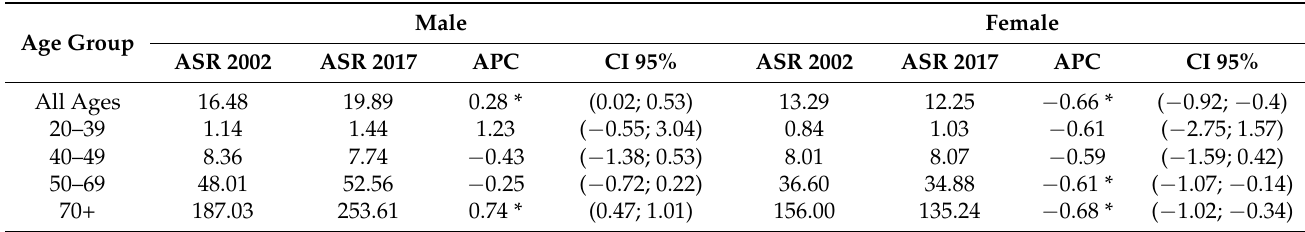
Table 3. Colorectal cancer mortality age standardized rates per 100,000 (ASR); annual percent change (APC) and 95% confidence interval (CI) by age group and sex, Uruguay,